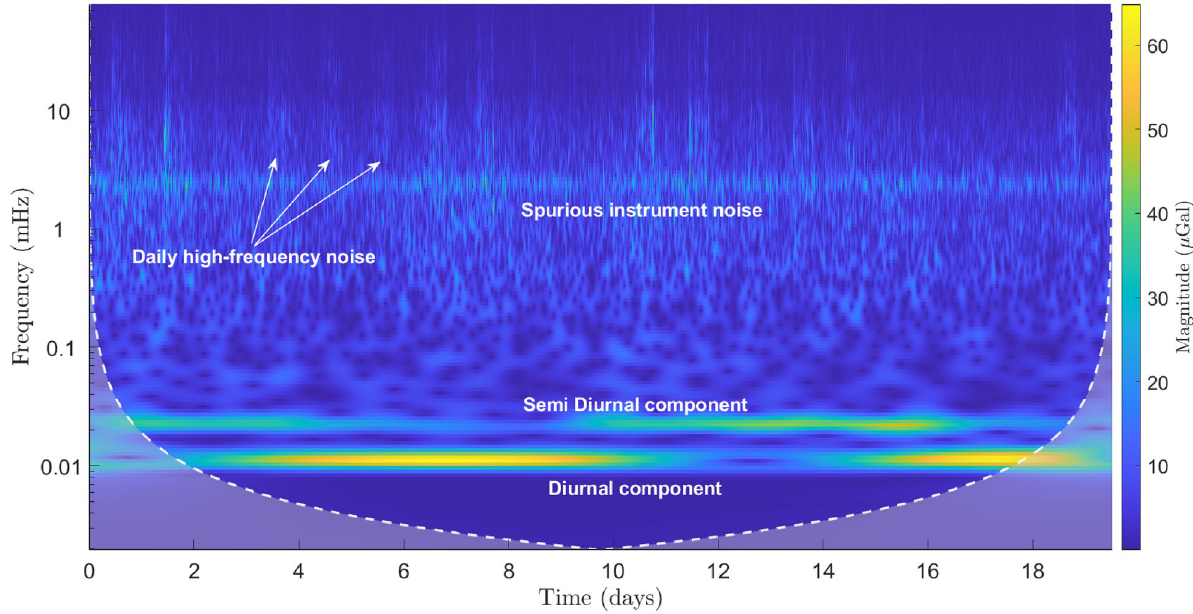
Figure 7. A scalogram graph of the MEMS data generated using continuous wavelet analysis on Matlab. The double Earth tide peaks are visible at the lower frequencies while the higher frequency band consists of a continuous spurious signal arising from the temperature control electronics and intermittent high frequency